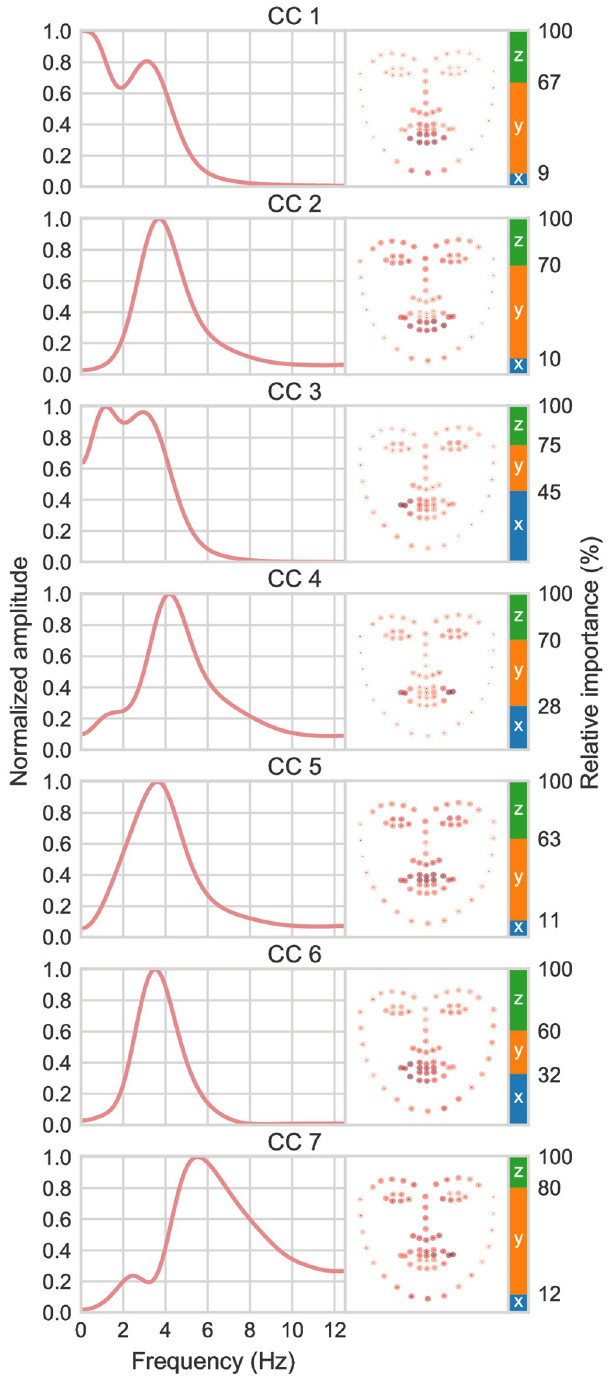
Fig 4. CCA results for the GRID dataset. CCA-derived envelope filters ( left ) and corresponding face loadings ( right ) for the GRID dataset. Unlike in the wild recordings of natural speech such as the LRS3, the GRID corpus is composed of simple, syntactically identical six-word